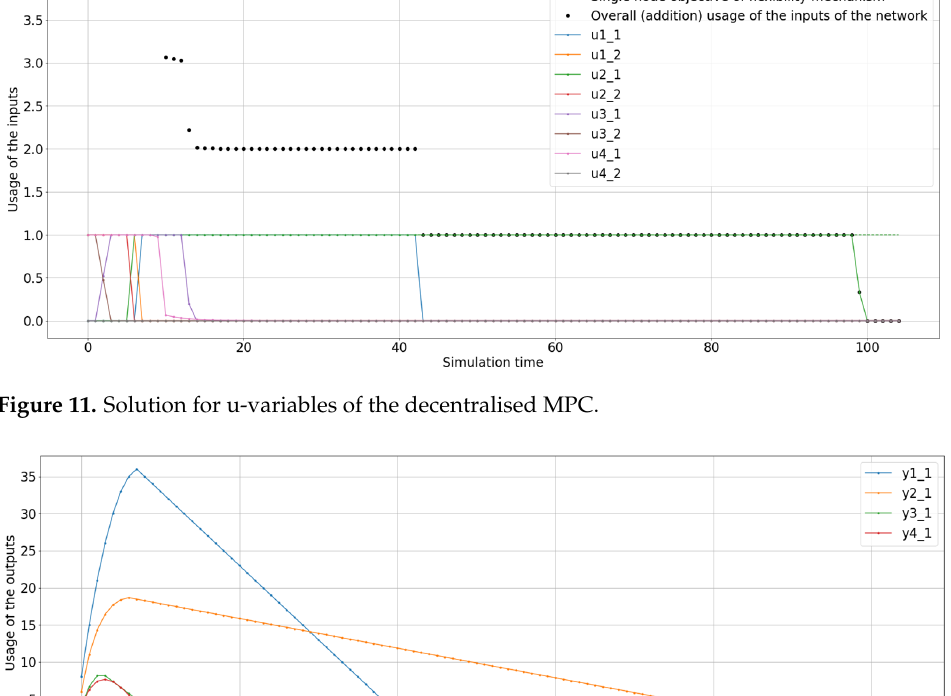
Figure 11. Solution for u-variables of the decentralised MPC.